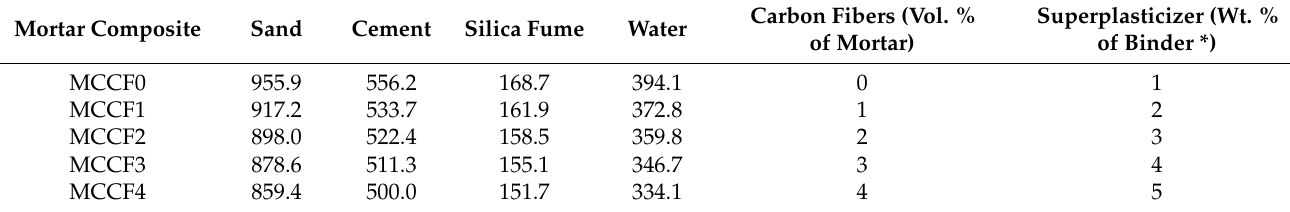
Table 1. Corrected mix proportions of various mortar composites.